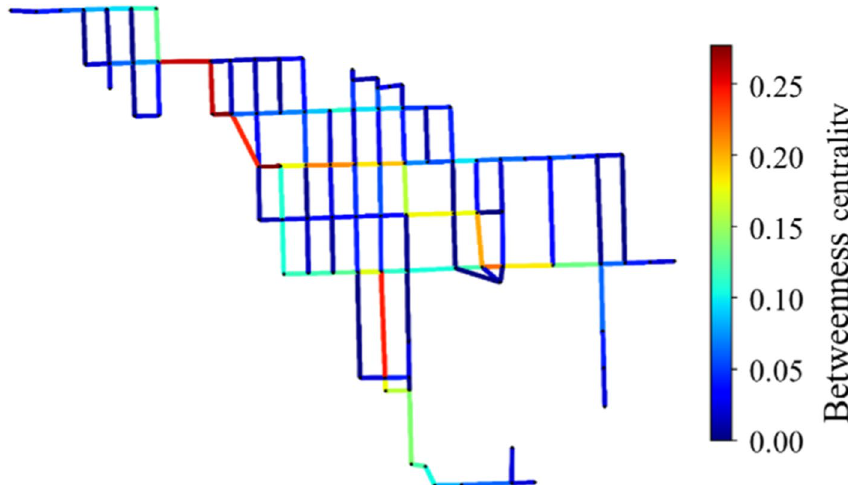
Fig. 8 The map of betweenness centrality values of the road